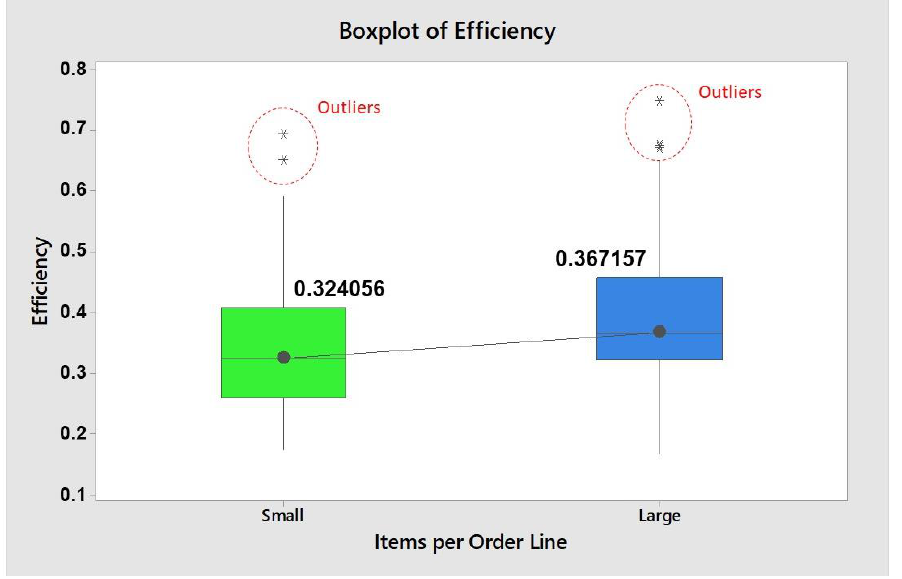
Figure 12. Boxplot of order-picking time for items per order line (* represents outlier values).